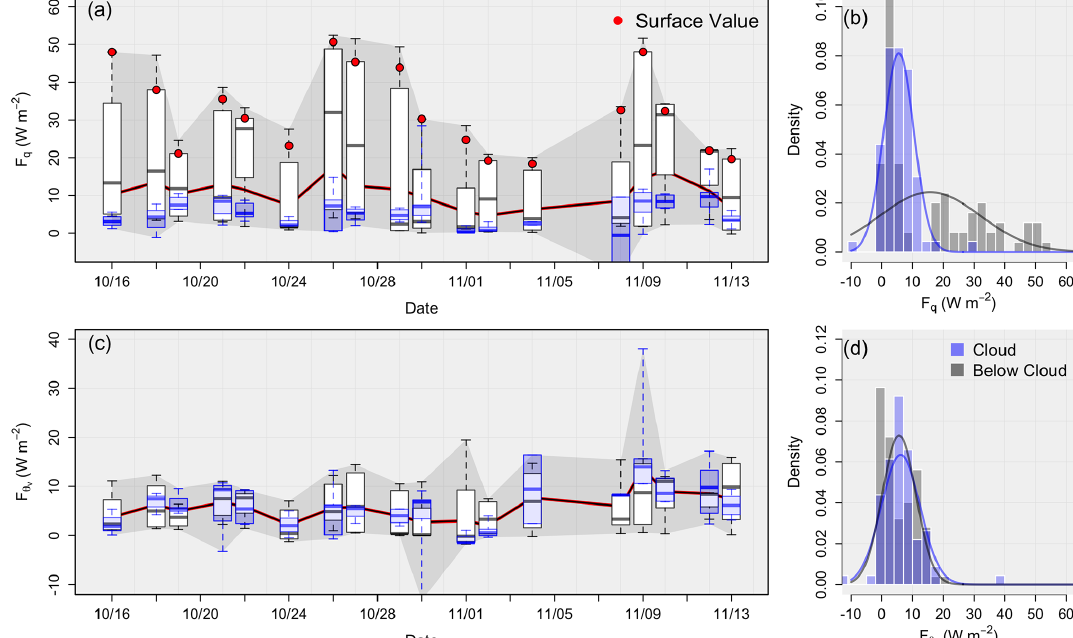
Figure 8. Box plots of in-cloud (blue) and sub-cloud (white) data using mean values of horizontal flight legs for (a) F q (Wm − 2 ) and (c) F θ (Wm − 2 ). The gray envelope represents the range of the data, while the red line represents the mean value for each flight. Panels (b) and (d) provide the distribution of the data populations (with normal distributions overlaid for reference) for F q and F θ